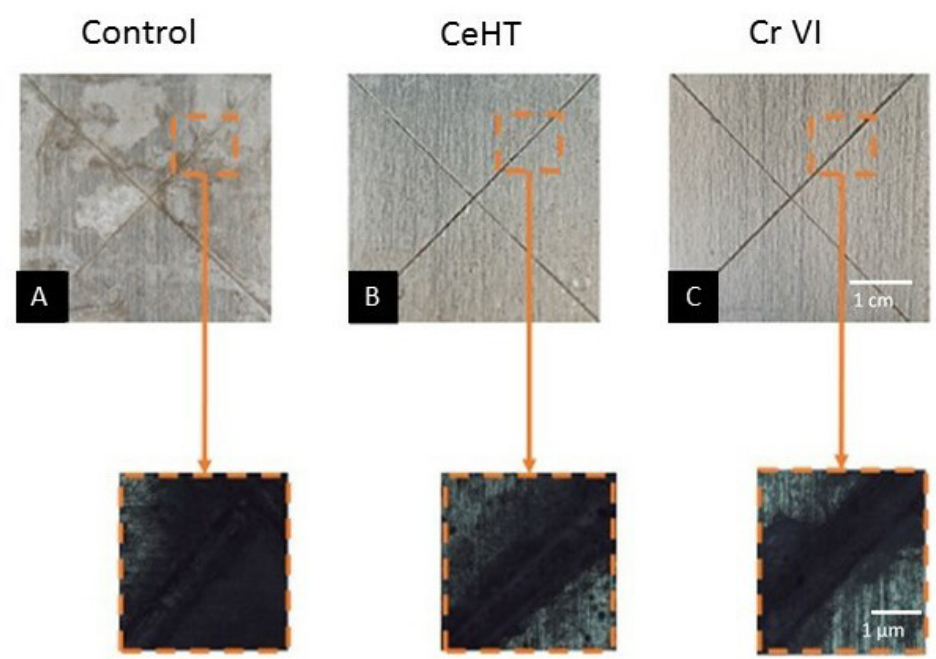
Figure 9. Visual aspect of samples of AA1230 clad on AA2024 alloy in the surface condition (A) Control, (B) CeHT treated NS (C) CrVI